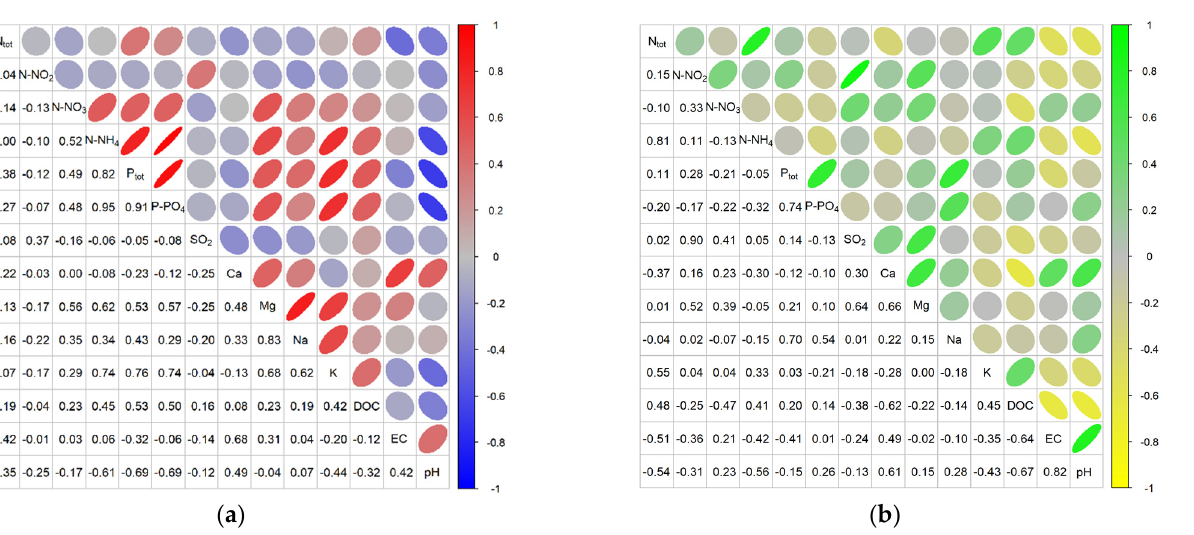
Figure 7. Correlations between physicochemical factors of peatland water as pooled data for Menyanthes trifoliata in 2011–2013 ( a ) abundant sites, ( b ) non-abundant sites.